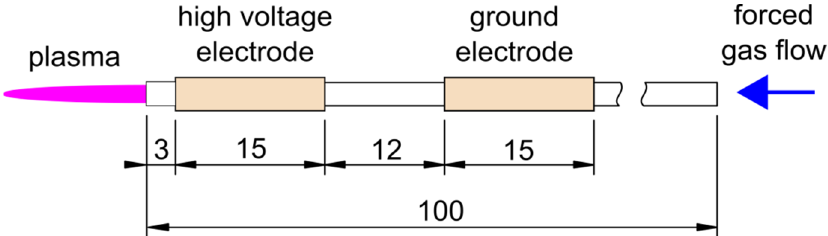
Figure 1. Geometry of DBD APPJ reactor, dimensions are given in mm.